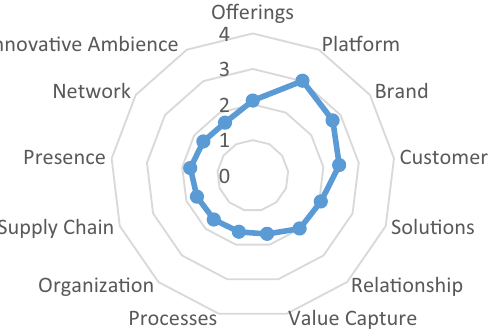
Figure 2. IR of MSEs by